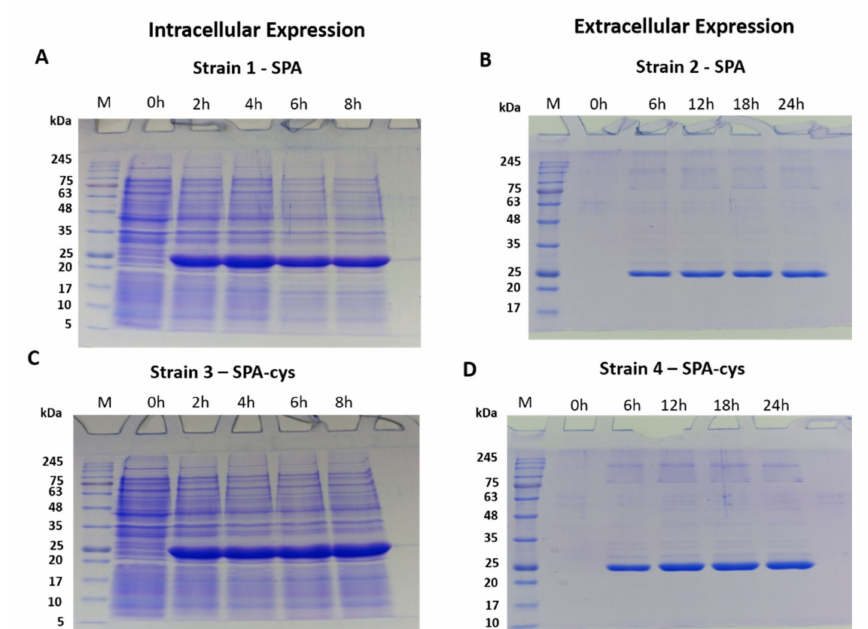
Figure 1. 12% reducing SDS-PAGE gel showing post induction expression studies up to 8 h for intracellular protein ( A : Strain 1- SPA, C : Strain 3- SPA-cys) and up to 24 h for extracellular protein ( B : Strain 2- SPA, D : Strain 4- SPA-cys). Lane M: pre-stained molecular weight marker, Lane 0 h: pre induced, Lane 2–8 h: post induction samples at 2 h, 4 h, 6 h, and 8 h (Strain 1 and Strain 3). Lane